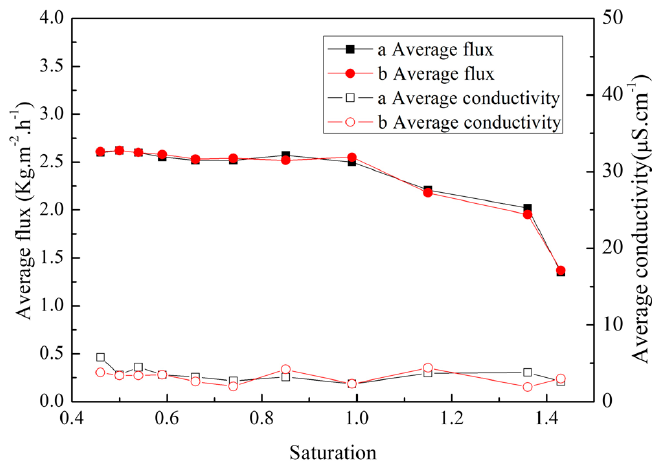
Figure 2. Evolution of flux and water yield conductivity during the membrane distillation (MD) operation. (a) ZnSO 4 solution; (b) NiSO 4 solution.